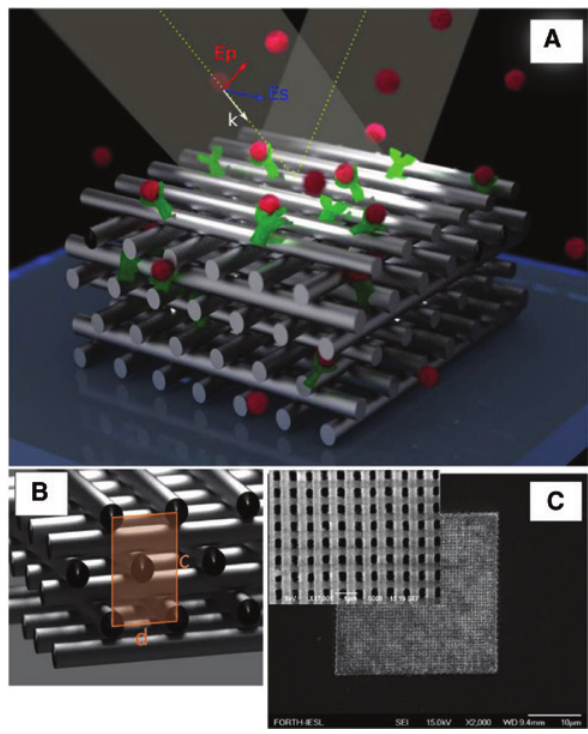
Figure 9: A 3D plasmonic metamaterial nanoarchitecture offering a large area for biomolecule immobilization with a much improved spectral sensitivity of 2600 nm/RIU. The structure is based on Ag- coated woodpile crystal produced by multiphoton laser polymeriza- tion, followed by Ag-based metallization. (A) Schematic illustra- tion of biosensing using the metamaterial. A receptor (green) is immobilized inside the woodpile structure and its selective partner (red) binds to the receptor sites, leading to a change of parameters for the reflected light. (B) Schematic representation of a woodpile crystal. (C) SEM image of the structure. Reprinted with permission from Ref.